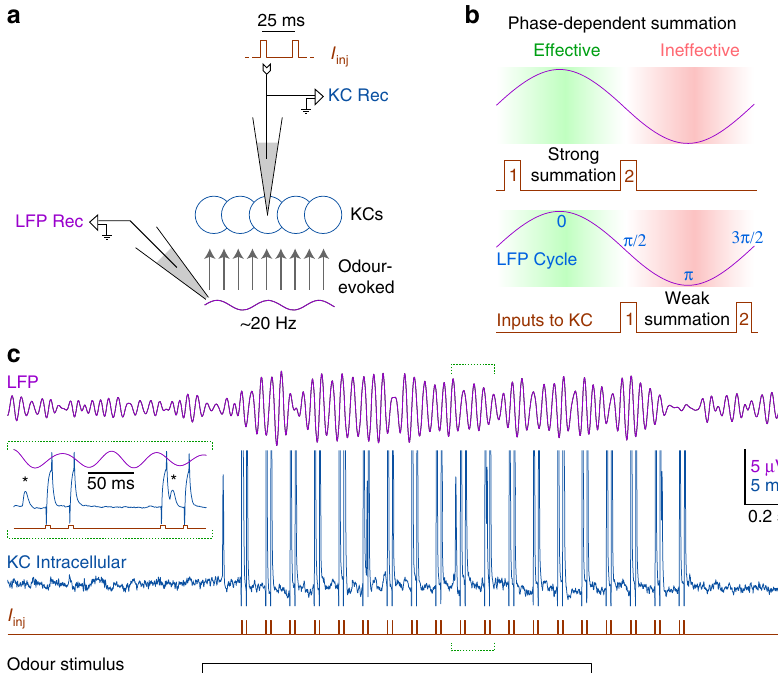
Figure 1 | Experiment design. ( a ) Recording configuration: In locusts, oscillating waves of odour-evoked spikes are carried by projection neurons from the antennal lobe to Kenyon cells (KCs). A blunt electrode in the mushroom body monitored the odour-evoked oscillatory local field potential (LFP Rec) while an intracellular electrode in a KC (KC Rec) recorded membrane potential and injected pulses of current ( I inj ). ( b ) Experiment strategy: By injecting pairs of current pulses into KCs (upper and lower panels show two such pairs) we tested the effect of phase position on input summation. ( c ) Example experiment from n ¼ 16 KCs: LFP oscillations (purple, top) were induced by a 2-s odour presentation (black, bottom). The second trace (blue) shows a simultaneous intracellular recording from a KC. In each trial, the KC received 19 pairs of intracellular current pulses ( I inj , red) with the following parameters: pulse- width ¼ 5ms; inter-pulse interval ¼ 25ms (onset-to-onset); inter-pair interval ¼ 125ms (onset-to-onset). Each neuron received at least 20 trials. Inset: A 210-ms period spanning the 10th and the 11th pulse pairs. Although current injections caused large artefacts in the recording, spikes (marked with asterisks) could be identified between or superimposed with the stereotyped